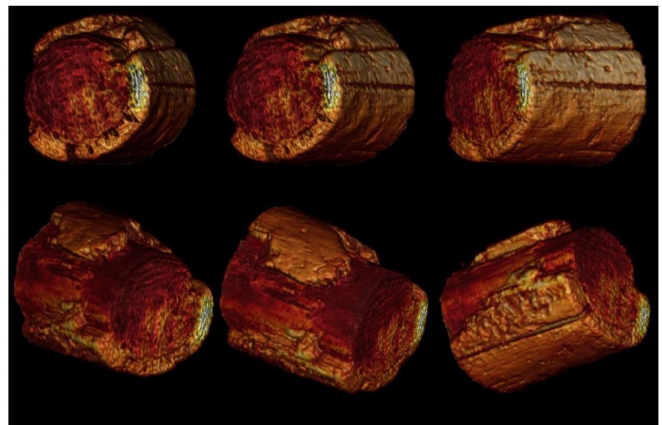
Figure 11. Color-coded 3D MRI from different views of waterlogged archaeological wood from